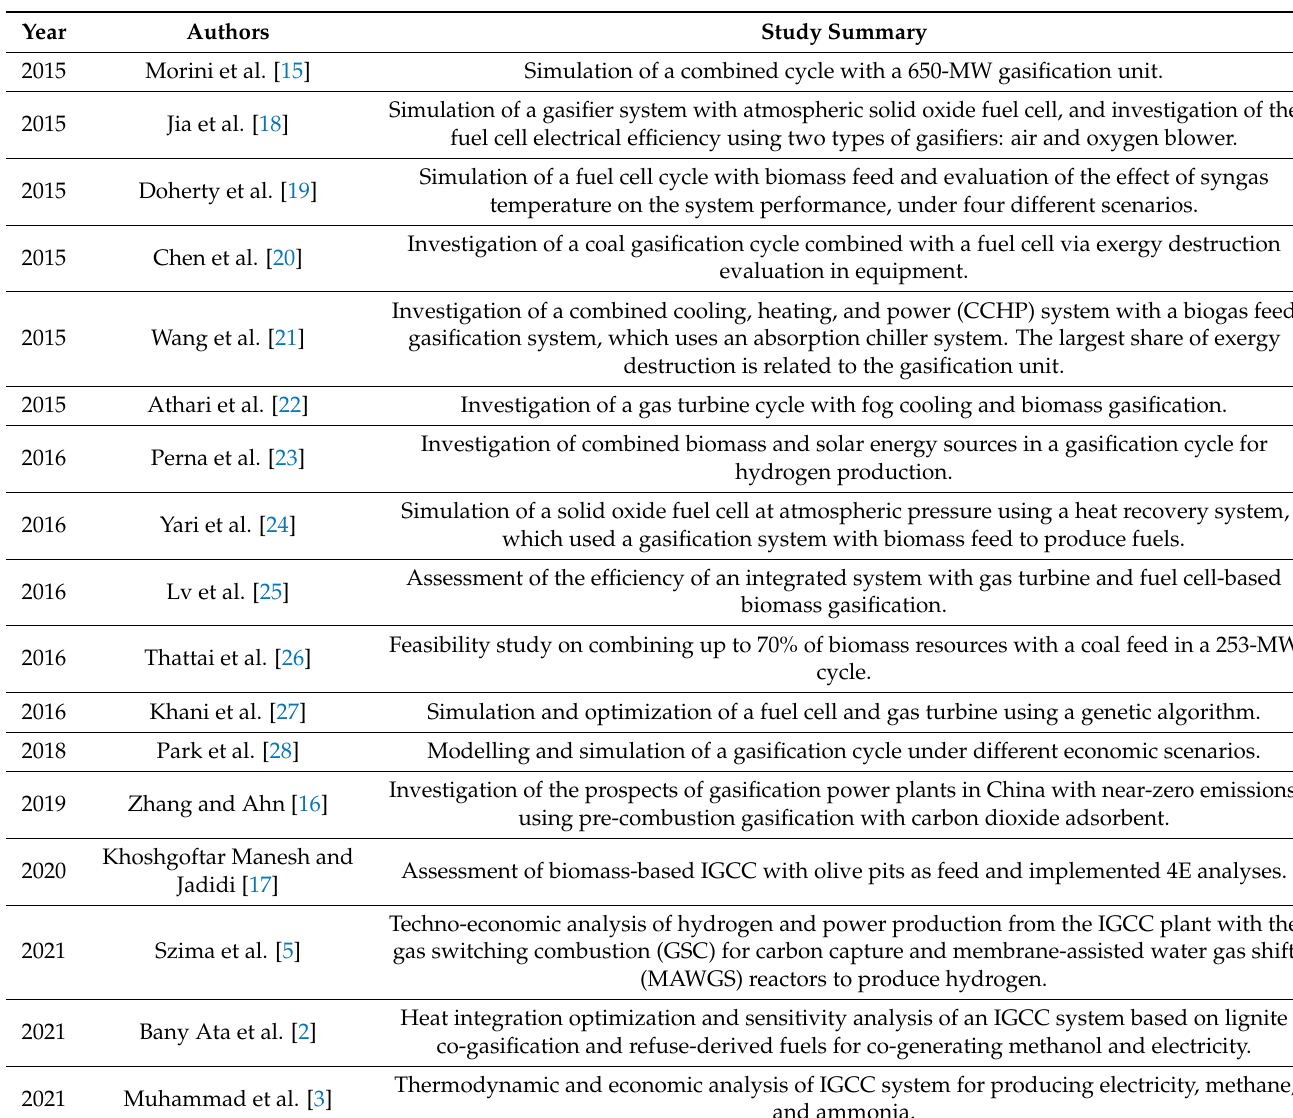
Table 1. A brief review of the most recent literature on the applications, methods, and practices related to integrated gasification combined cycles